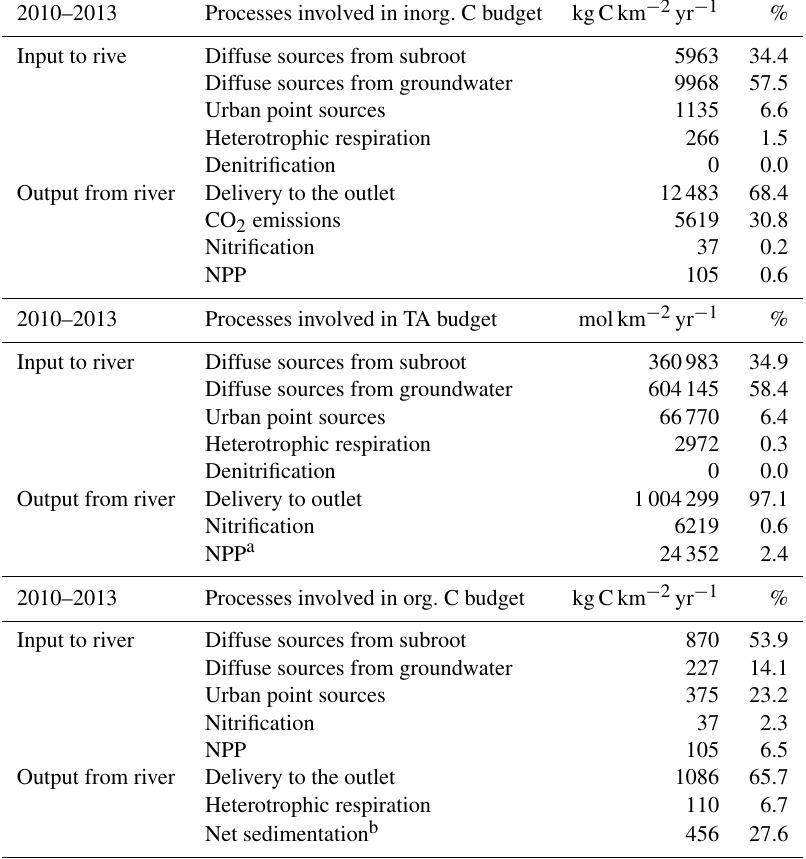
Table 4. Budget of the Seine hydrosystem for inorganic and organic carbon (kgCkm − 2 yr − 1 ) and total alkalinity (TA, molkm − 2 yr − 1 ) as calculated by the pyNuts-Riverstrahler model averaged over the period 2010–2013. a TA input related to NPP refers to the net difference between TA produced by photosynthesis on NO 3 uptake and photosynthesis on NH 4 uptake (reducing alkalinity). b Net sediment loss is the difference between the erosion and the sedimentation calculated by the